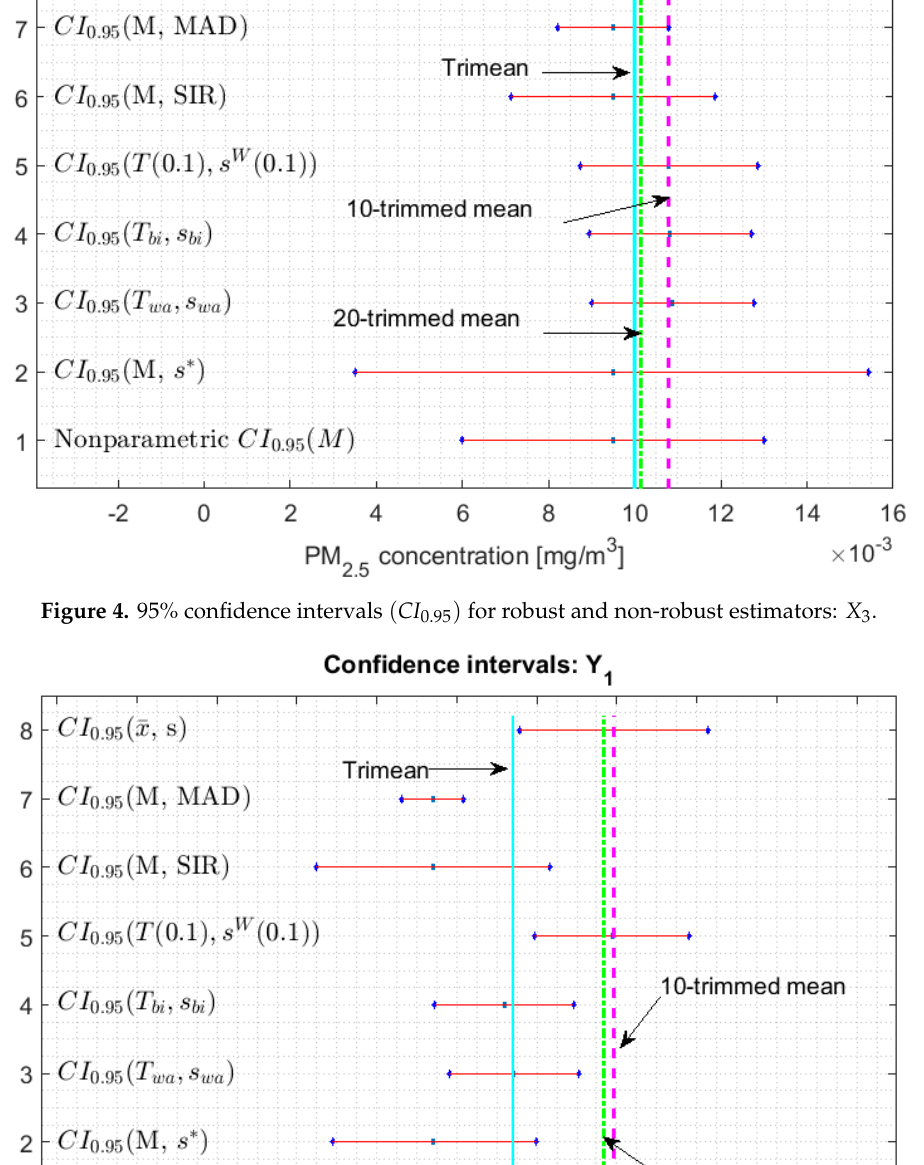
Figure 3. 95% confidence intervals (𝐶𝐼 (cid:2868).(cid:2877)(cid:2873) ) for robust and non-robust estimators: 𝑋 (cid:2870) .